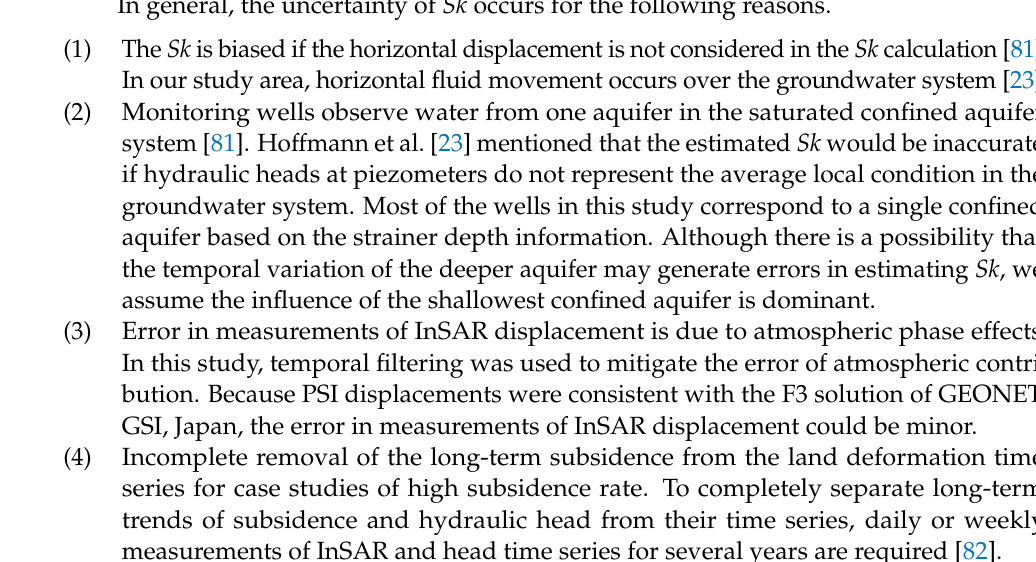
Figure 9. Mapped storage coefficient for the confined aquifer in the study area. Triangles indicate well locations.